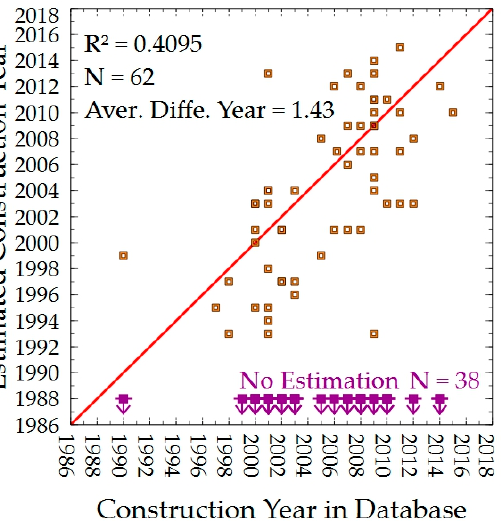
Figure 33. Comparison of the database and estimated years of construction of 100 short bridges. The plotted points are not far from the red line, indicating good accuracy.